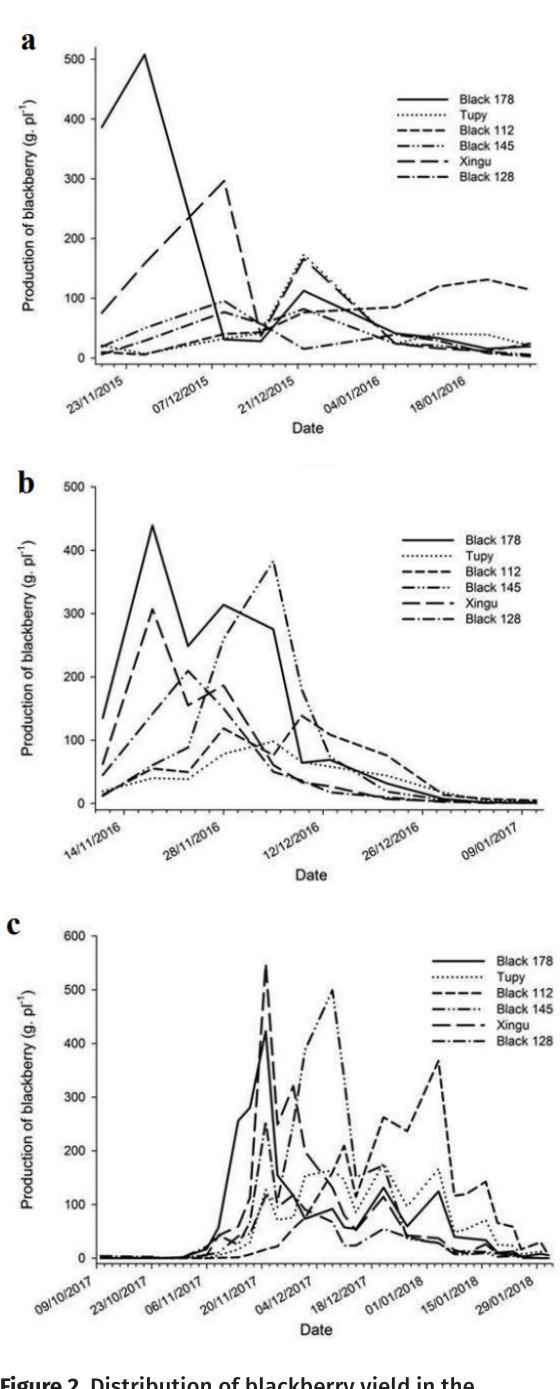
Figure 2. Distribution of blackberry yield in the production cycle 2015-2016 (a); 2016-2017 (b); 2017-2018 (c). Pelotas, RS,